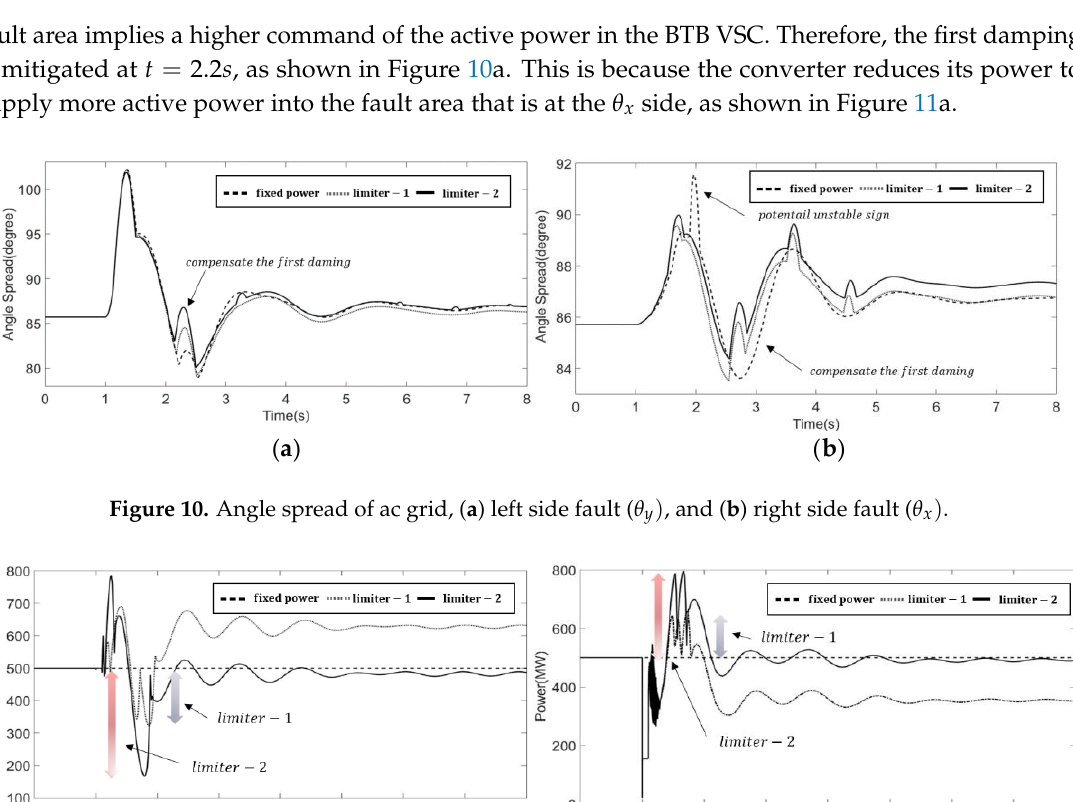
Table 2. The effect of the first power control scheme in other contingencies.